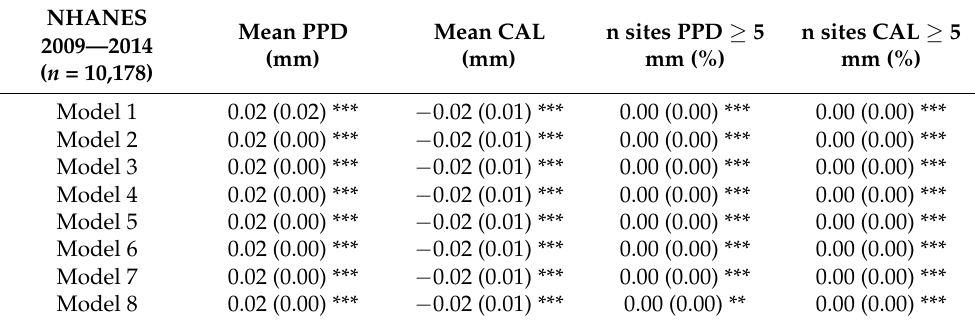
Table 3. Crude and adjusted linear regression models and correspondent standard error towards mean PPD, mean CAL, PPD ≥ 5 and CAL ≥ 5 with DII for the overall samples ( n =